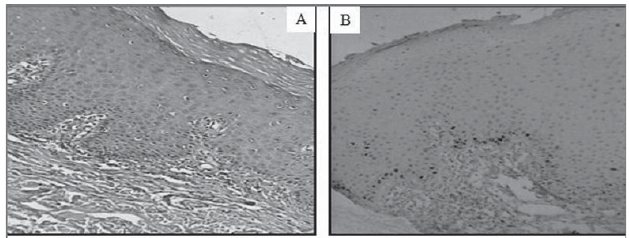
Fig. 3 H/E (A) and IHC staining with p53 expression (B) showing moderate dysplasia (10x).